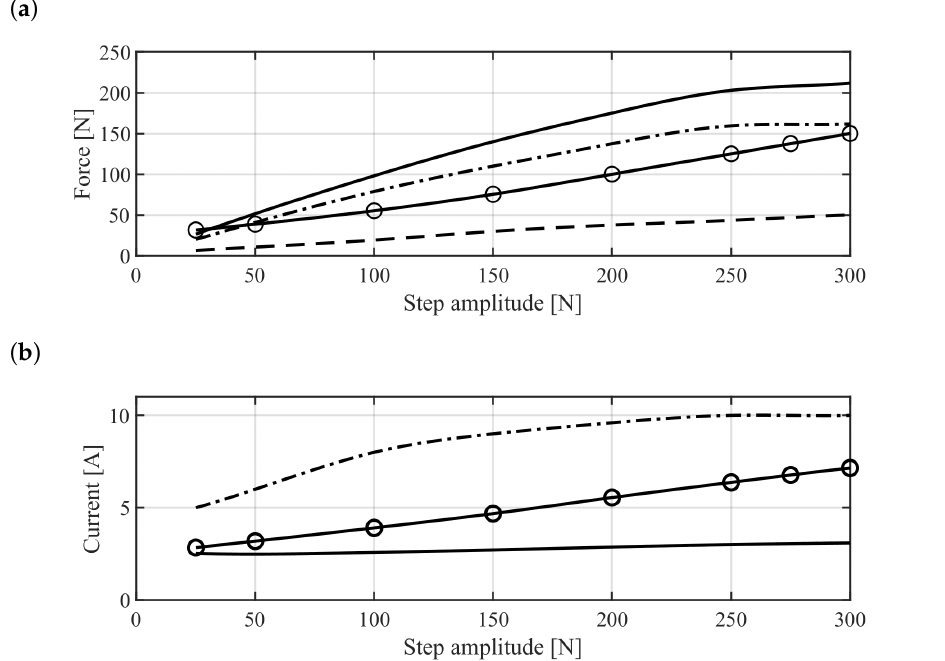
Figure 13. ( a ) Force provided by the most loaded electromagnet at steady state vs external force step applied to the rotor center of mass. Solid: total force (hysteretic rotor material case). Dash-dotted: residual force (hysteretic). Dashed: current-related force (hysteretic). Solid with circles: total force (linearized rotor material case). ( b ) Current supplied to the most loaded electromagnet at steady state vs external force step applied to the rotor center of mass. Solid: current (hysteretic rotor material case). Dash-dotted: maximum current overshoot (hysteretic). Solid with circles: current (linearized rotor material